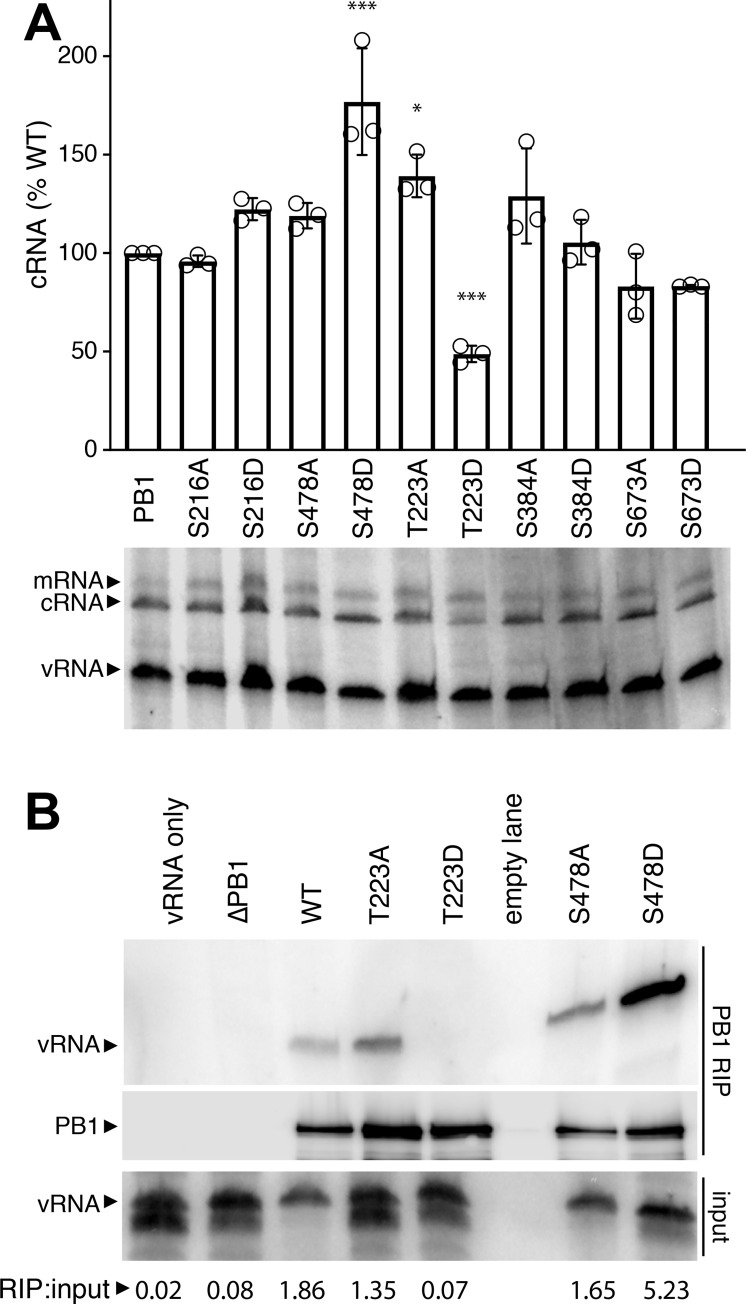
Phosphorylation at T223 inhibits cRNA stabilization and vRNA binding.A. PB1 phospho-mutants were tested in a cRNA stabilization assay. WT or mutant PB1 and oligomerization-deficient NP (NPE339A) were expressed in 293T cells. Cells were treated with actinomyocin D (ActD) prior to infection, RNA extraction and primer extension analysis to detect transcription (mRNA) and replication (cRNA, vRNA) products. A representative primer extension gel is shown. cRNA levels were quantified, normalized to WT, and expressed as mean ± sd. * < 0.05, ** < 0.01, *** < 0.001 = P for one-way ANOVA with Dunnett’s post hoc compared to WT. B. PB1 T223D fails to precipitate vRNA in an RNA-IP (RIP). PB1-FLAG, PB2, PA, and segment 6 vRNA were expressed in 293T cells. Cells were lysed and subject to FLAG immunoprecipitation. RNA extracted from immunoprecipitates and input samples was probed for the presence of segment 6 vRNA via primer extension analysis. Immunoprecipitated PB1 was confirmed via western blot. The ratio of radiolabel quantified for RIP and input is shown at the bottom.